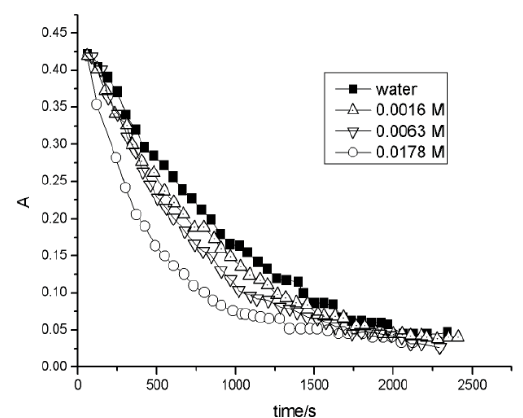
Figure 1. Integral kinetic curves for malachite green fading in the presence of